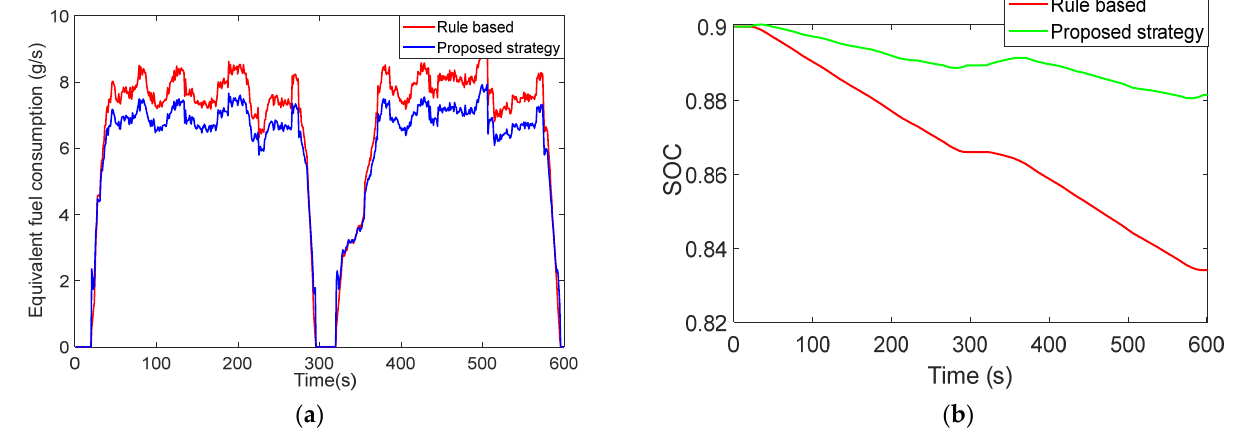
Figure 11. The results of the proposed strategy. ( a ) The optimized equivalent fuel consumption. ( b ) The SOC curve of battery in rotary tillage conditions.